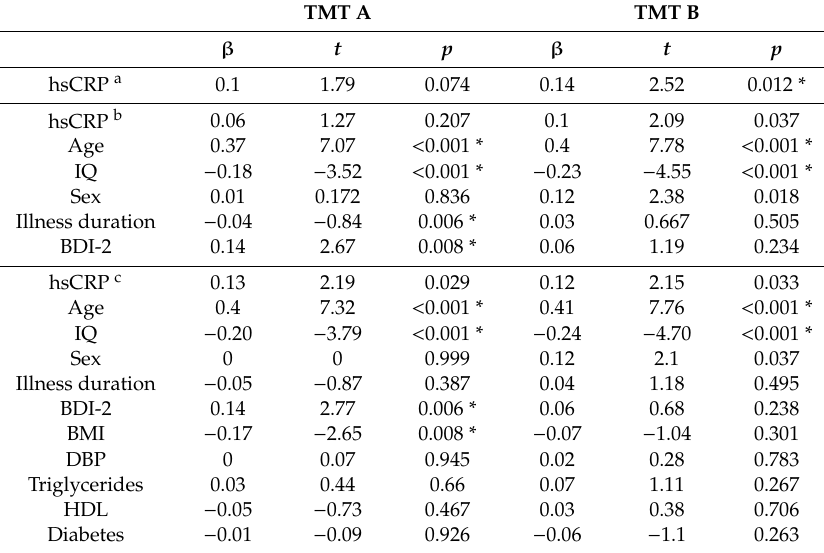
Table 3. The association of serum hsCRP concentration with linear multiple regression on Trail-Making Test performance ( N = 335).